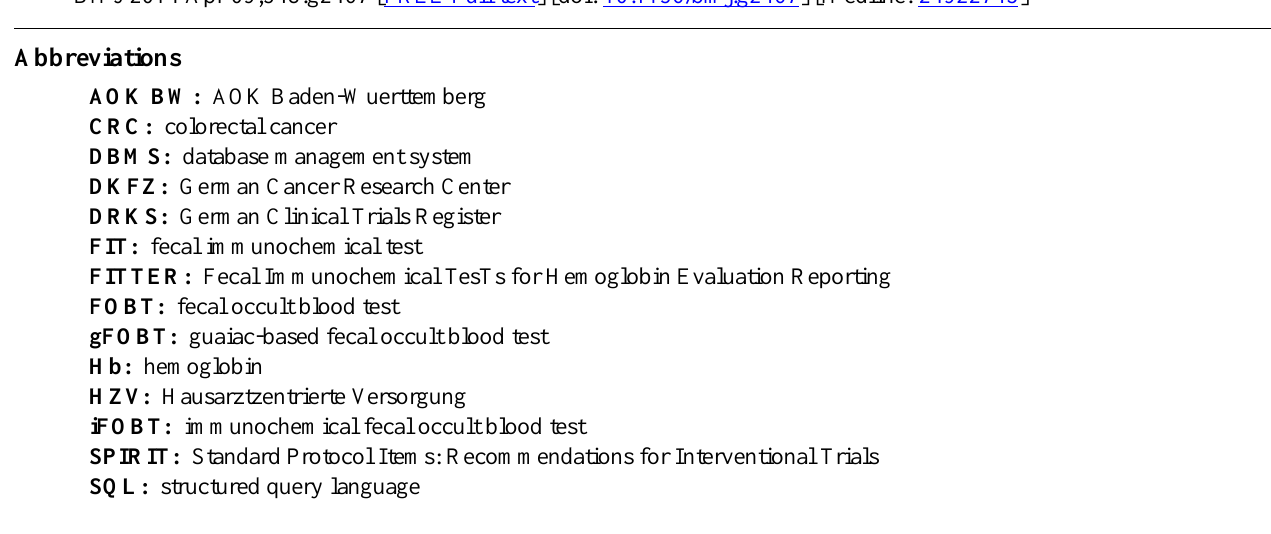
SPIRIT: Standard Protocol Items: Recommendations for Interventional Trials SQL: structured query